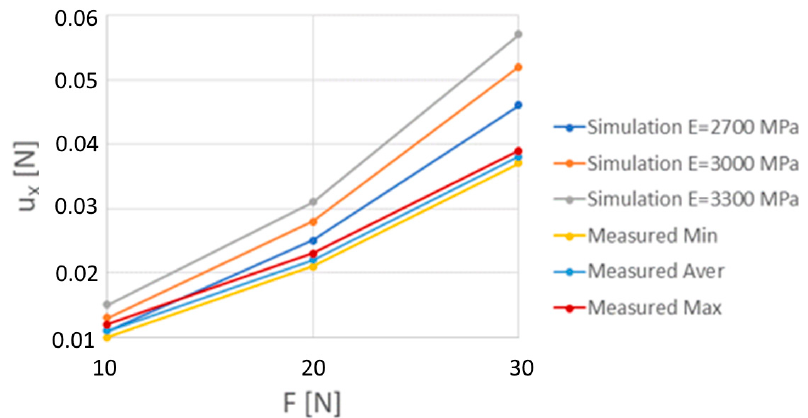
Figure 21. Displacement 𝑢 (cid:3025) as a function of force F obtained from simulations and measurements.